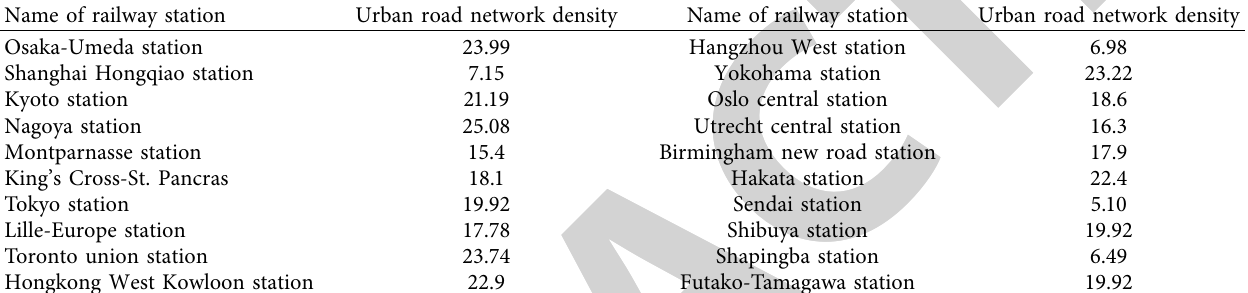
Table 7: Entire urban road network density with the corresponding station catchment